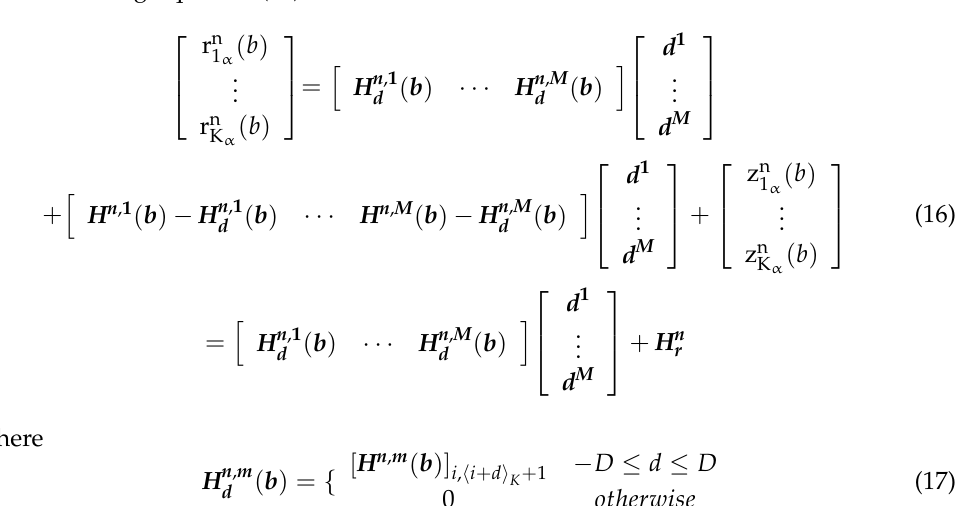
Figure 3. The desired structure of 𝑯 (cid:3561) Then, the output vectors related to 𝑖 (cid:3047)(cid:3035) subcarrier r (cid:2919)_(cid:2961)(cid:2924) (cid:4666)𝑏(cid:4667) are extracted from equa ‐ tion (16), leading to